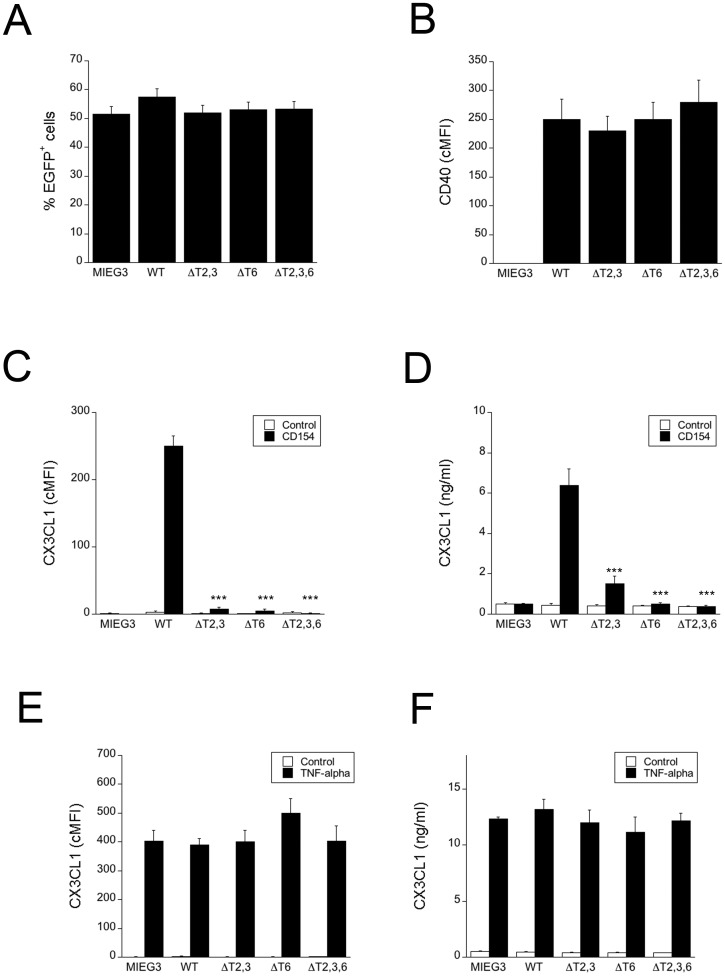
Both the CD40-TRAF2,3 and CD40-TRAF6 binding sites are required for optimal CX3CL1 upregulation in HAEC.HAEC were transduced with MIEG3-based retroviral vector that encode EGFP and either wt CD40, CD40 ΔT2,3, CD40 ΔT6, CD40 ΔT2,3,6. (A) Percentages of HAEC that became EGFP+ after incubation with retroviral vectors. (B) Expression of CD40 on gated EGFP+ cells shown as cMFI. (C, D) HAEC transduced with the retroviral vectors were incubated with or without multimeric CD154 for 24 h. Expression of CX3CL1 (cMFI) on gated EGFP+ cells was assessed by flow cytometry (C) and CX3CL1 concentrations in supernatants were determined by ELISA (D). (E, F) HAEC transduced with the retroviral vectors were incubated with or without TNF-α for 24 h. Expression of CX3CL1 (cMFI) on gated EGFP+ cells was assessed by flow cytometry (E) and CX3CL1 concentrations in supernatants were determined by ELISA (F). Results are shown as mean ± SEM and are representative of 3 experiments. *** p < 0.001.